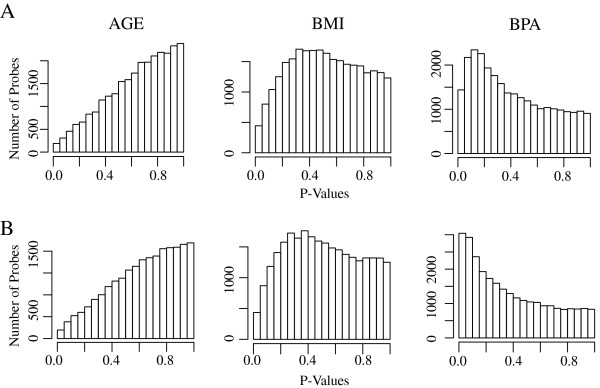
Histogram of p-values (bin = 0.1) in methylation analysis using covariates including age, BMI, and log BPA in empirical Bayes modeling using LIMMA package in R software with BPA as a (A) dichotomous or (B) continuous variable.